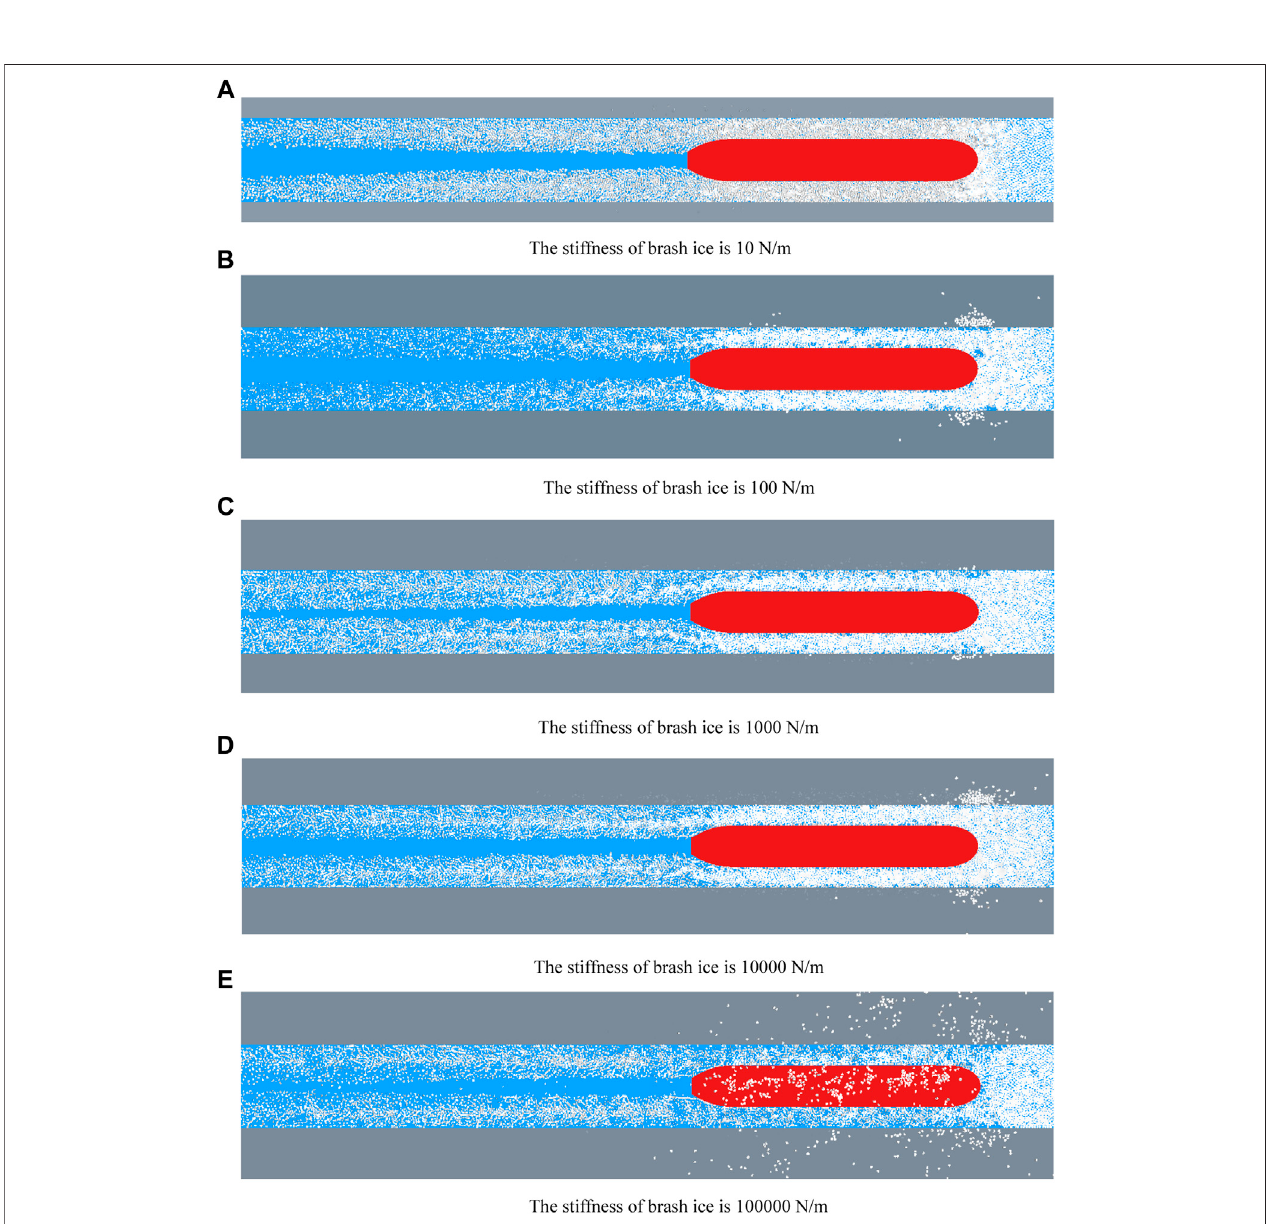
FIGURE 8 | In fl uence of stiffness on the motion of brash ice.